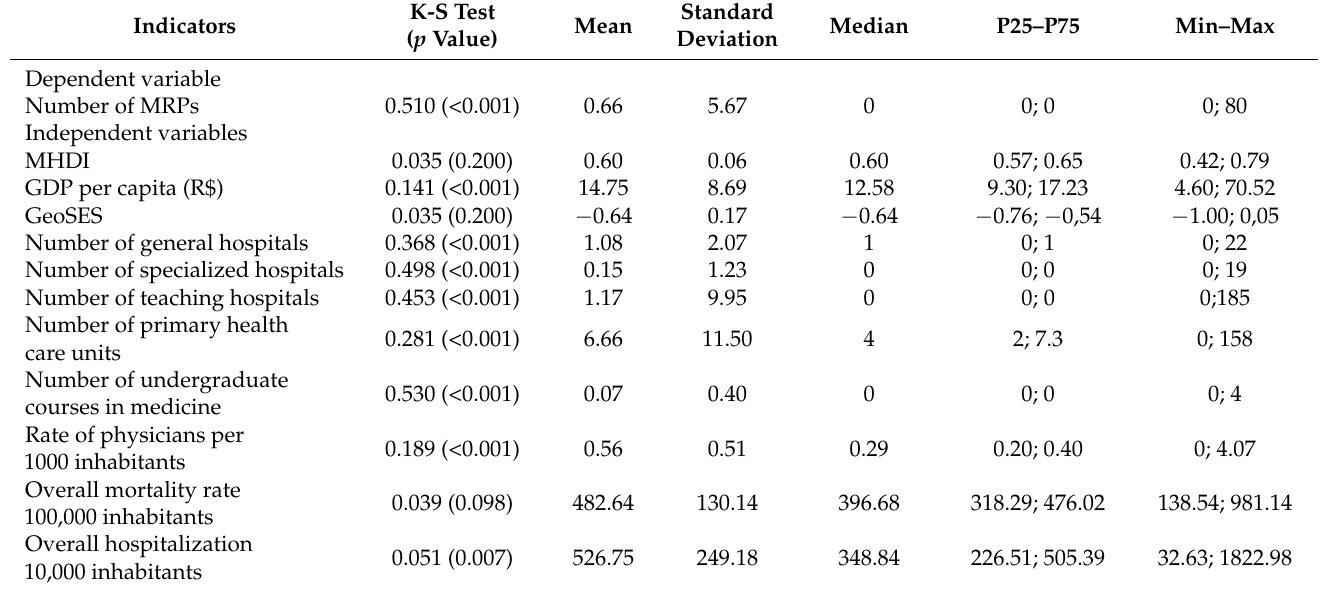
Table 4. Descriptive analysis of number of MPRs and contextual (socioeconomic, structural, and epidemiological).